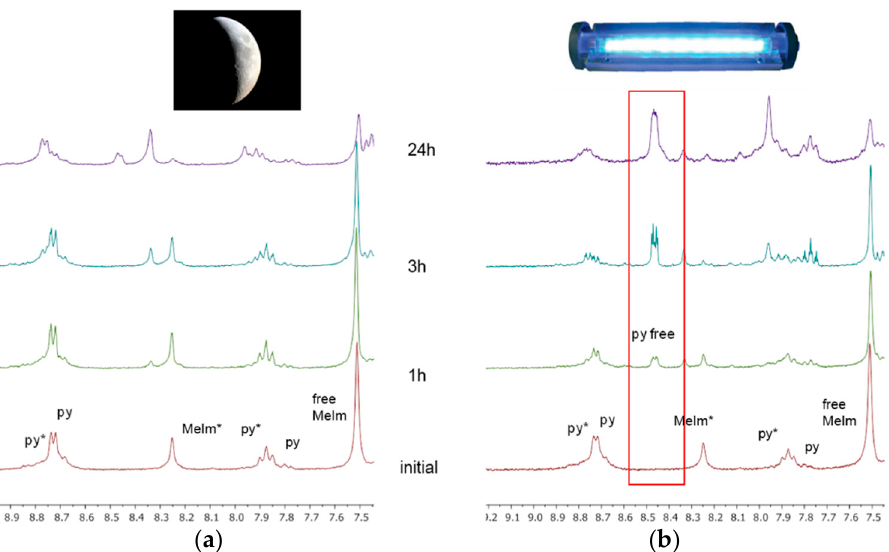
Figure 5. Progress of the reaction between complex 1 and MeIm monitored by 1 H NMR (acetone ‐ d 6 and D 2 O in a ratio 2:1) showing changes in the aromatic area. Labels: py, pyridine ligand complex 1 ; py*, pyridine signal adducts, MeIm*, N ‐ Methylimidazol signal adducts, free MeIm, free N ‐ Methylimidazol. ( a ) reaction at 37 °C and ( b ) reaction at 37 °C and irradiating